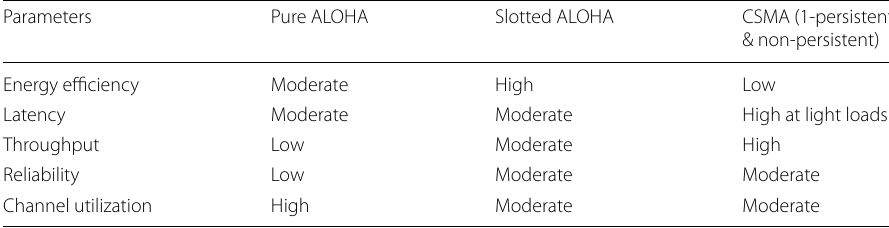
Table 3 Qualitative analysis of pure ALOHA, slotted ALOHA, and CSMA protocols [39–45]